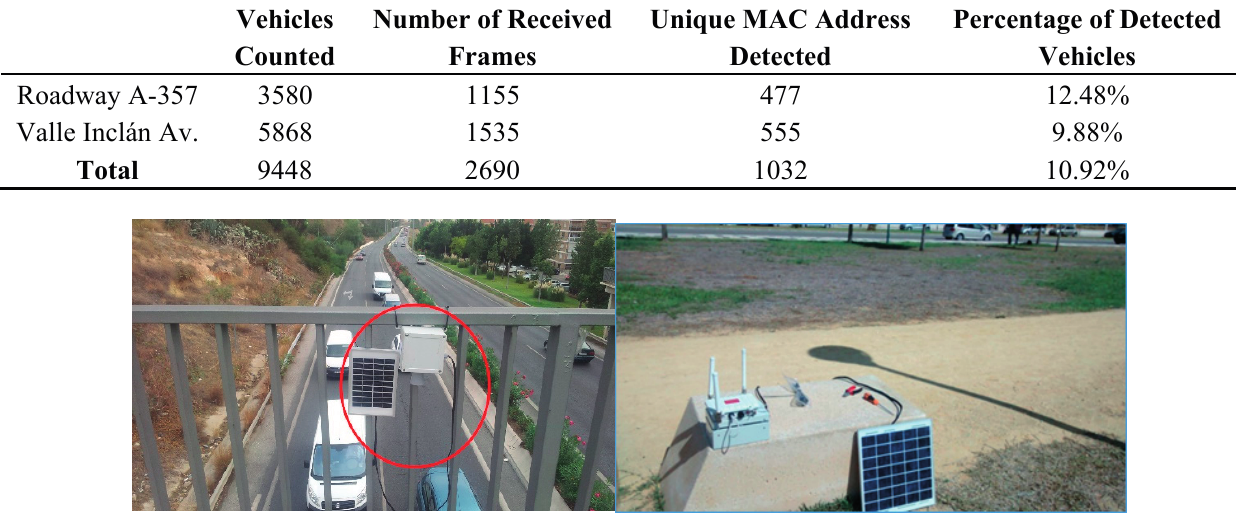
Figure 16. Different installations for UIS nodes. ( a ) UIS ULT node installation; ( b ) UIS Receiver node with solar